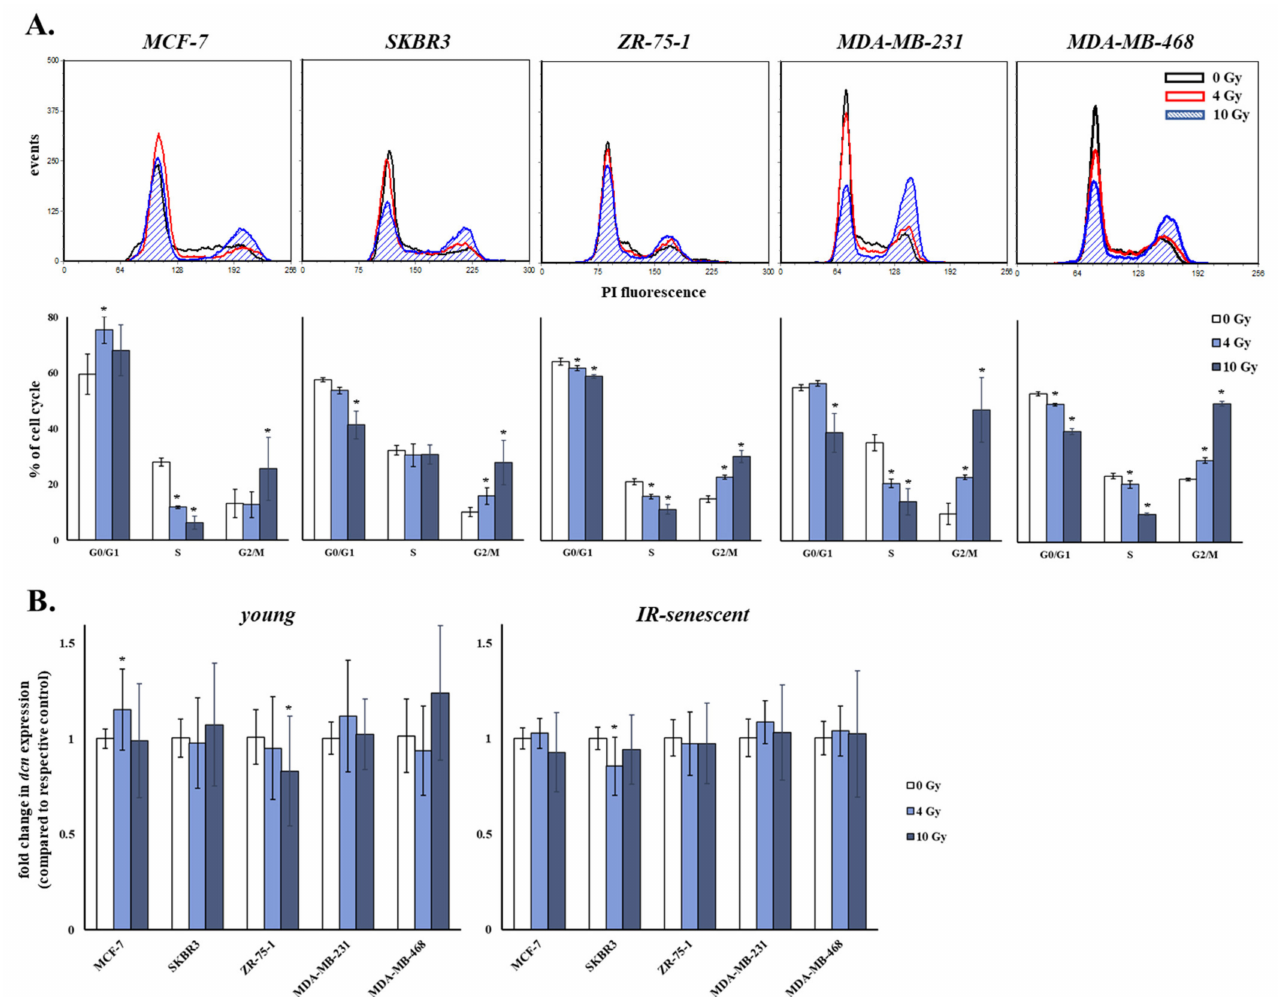
Figure 8. Ionizing radiation causes a cell cycle arrest in human breast cancer cells, which does not affect their paracrine effect on decorin expression of human breast stromal fibroblasts. ( A ) Breast cancer cells were exposed to 4 and 10 Gy of γ -irradiation. Cells were harvested after 24 h, stained with propidium iodide (PI) and analyzed by flow cytometry. Representative histogram plots are presented here, while the numerical values are the means ± standard deviations of three experiments. Asterisks (*) represent statistically significant differences in comparison to 0 Gy (Student’s t test, p < 0.05). ( B ) Young and ionizing radiation (IR)-induced senescent human breast stromal fibroblasts were serum starved for 24 h and then incubated with media conditioned by the designated human breast cancer cell lines (MCF-7, SKBR3, ZR-75-1, MDA-MB-231 and MDA-MB-468) treated with 0, 4 or 10 Gy for another 24 h. RNA was extracted and decorin expression was assessed by RT-qPCR. Relative decorin (dcn) mRNA levels to the respective control treated with the conditioned medium of 0 Gy are demonstrated as mean values ± standard deviations of three independent experiments. Glyceraldehyde-3- phosphate dehydrogenase (GAPDH) was used as the reference gene. Statistically significant differences from the respective control treated with the conditioned medium of 0 Gy are depicted by asterisks (*) (Student’s t test, p <